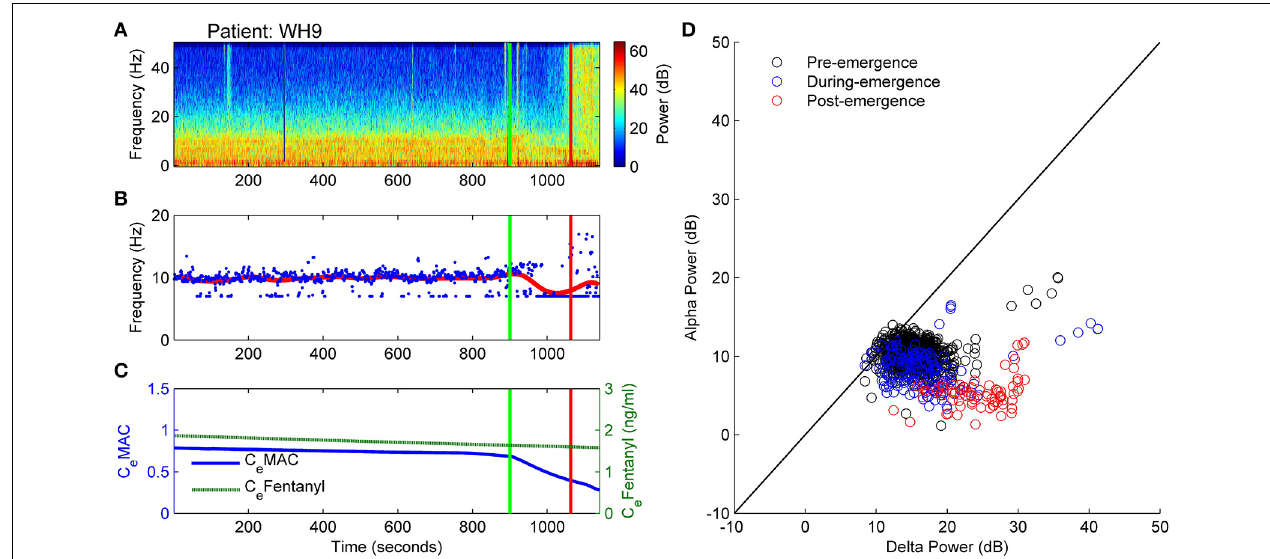
FIGURE 8 | Patient WH9: Non-archetypal emergence: minimal alpha loss, persistent theta and delta. (A) Spectrogram of the observation period. Start of emergence shown as a vertical green line at 900s, time of patient response as a vertical red line. (B) Frequency of maximal oscillatory alpha power. (C) Concentration of anesthetic gas (C e MAC),